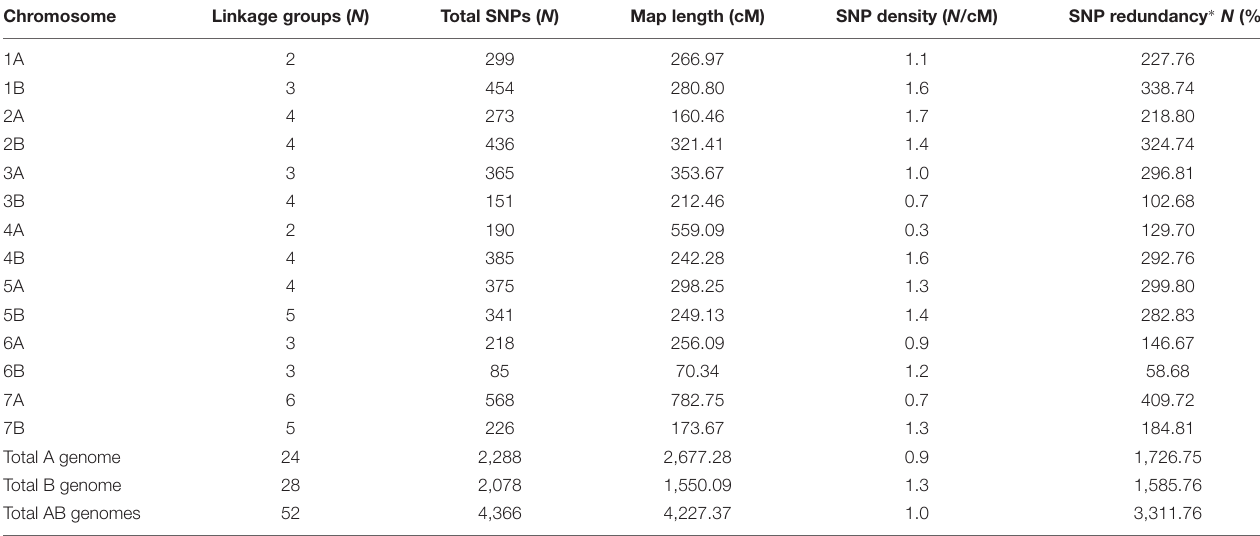
TABLE 4 | Number and distribution of SNP markers in the durum wheat genetic linkage map obtained in the 135 RILs from the cross between the hexaploid 02-5B-318 line (FHB-resistant) and the durum cv. Saragolla (FHB-susceptible).